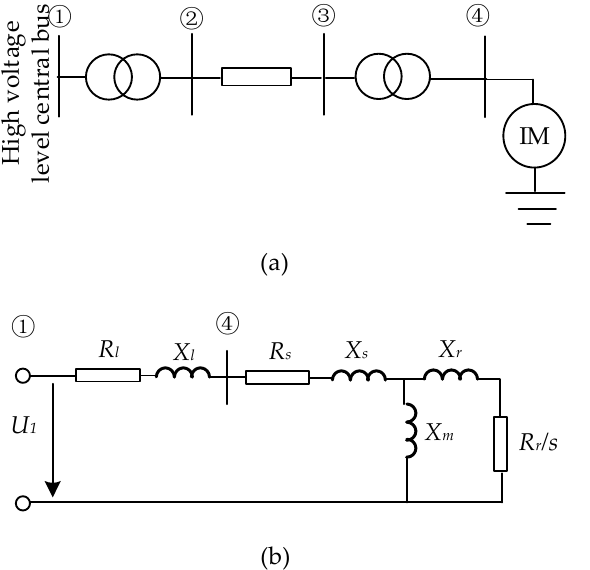
Figure 1. Single-load system: ( a ) structure of the single-load system; ( b ) equivalent circuit of the single-load system.